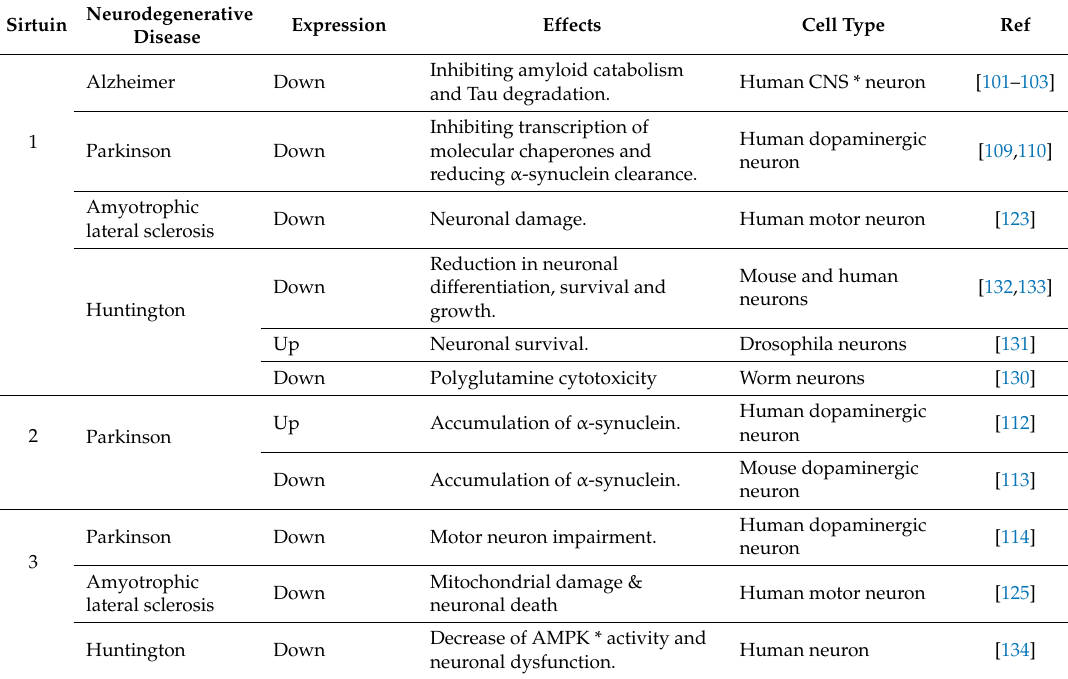
Table 4. Regulation and function of sirtuins in neurodegenerative disease. Neurodegenerative Sirtuin